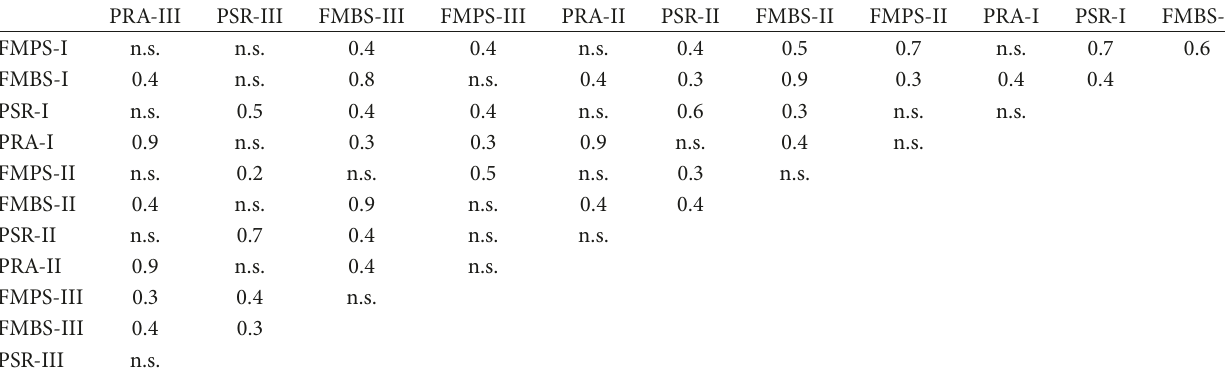
Table 4: Significance of dental indices at examination phase after Spearman